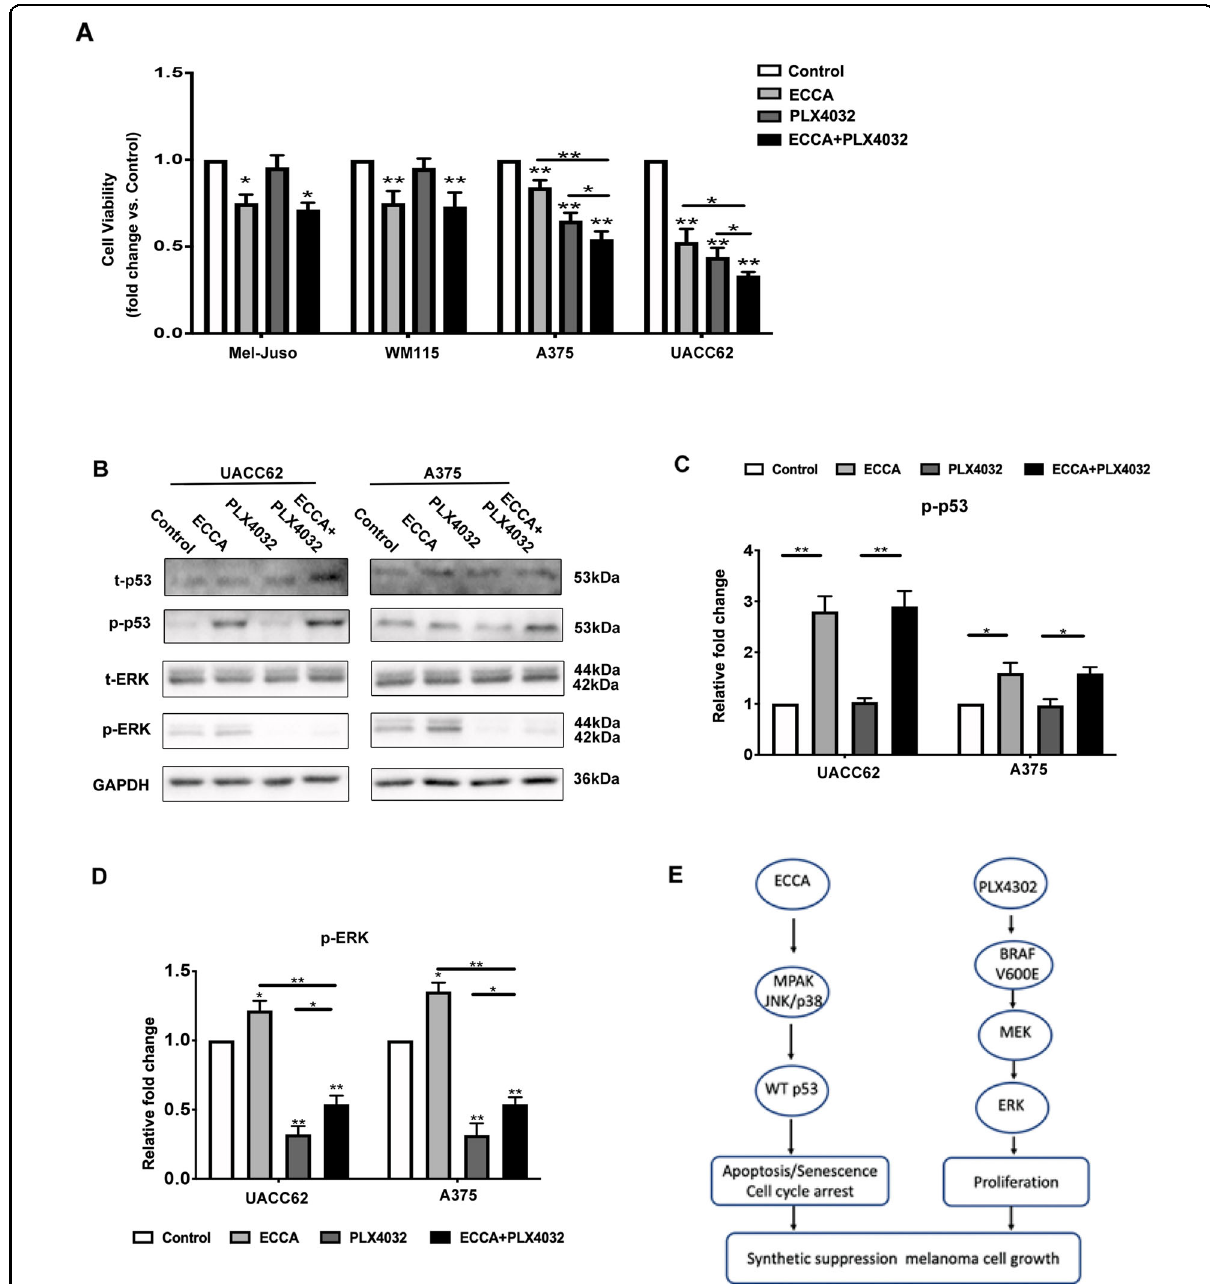
Fig. 7 ECCA signi fi cantly enhances the inhibition of melanoma cell growth together with a BRAFV600E inhibitor. A Four melanoma cell lines were treated with different conditions: DMSO (Control), 5 μ M ECCA, 1 μ M PLX4032 or 5 μ M ECCA + 1 μ M PLX4032. At 48 h, cells were collected and analyzed by the CCK8 assay for cell viability. B Immunoblotting analysis of phosphorylated and total forms of p53 and ERK proteins in UACC62 and A375 cells at 24 h treated with different conditions as A . C, D Quanti fi cation of the relative levels of phosphorylated p53 ( C ) and ERK ( D ) from blots in ( B ). E Scheme showing that ECCA and the BRAF V600E inhibitor target two separate pathways (p53-apoptosis and ERK-proliferation) in parallel to induce the synergistic suppression of melanoma cell growth. All experiments were carried out three times, and error bars represent means ± SD; P values are indicated with “ * ” , ** indicates P < 0.01 when comparing the corresponding two groups as indicated by lines in ( A , C , D